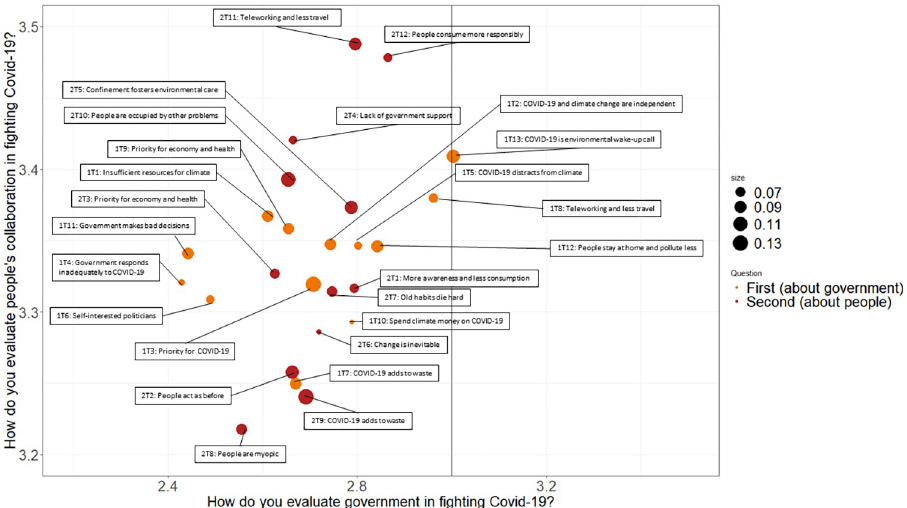
Fig 4. Positive vs negative evaluation of on actions of government and people in fighting COVID-19 for all topics generated. Note: Orange color indicates topics from the first open question (about climate actions by the government), and red from the second one (about climate actions by the people). Size of the topic reflects its prevalence in the overall set of responses. Position of each topic on the X- and Y-axes is the weighted average response on the Likert scale from 1 (very negatively) to 5 (very positively) on the corresponding closed questions.